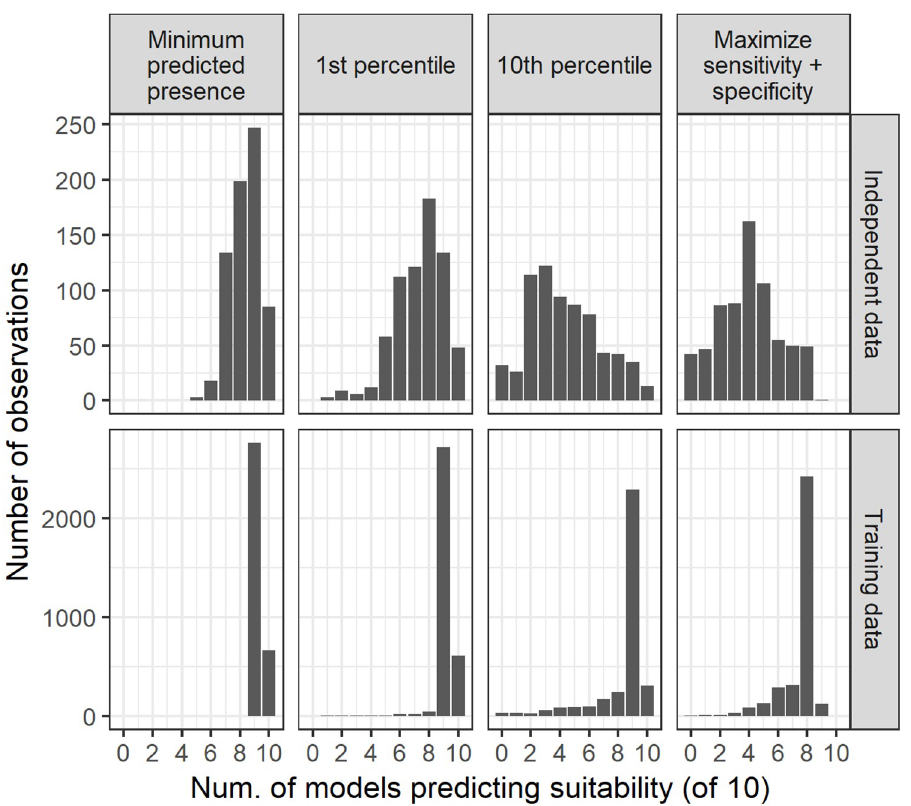
Fig 3. Model ensemble values associated with the independent observation data for fountain grass from CalFlora for four different threshold metrics including minimum predicted presence, one percentile, ten percentile and the maximum of sensitivity plus